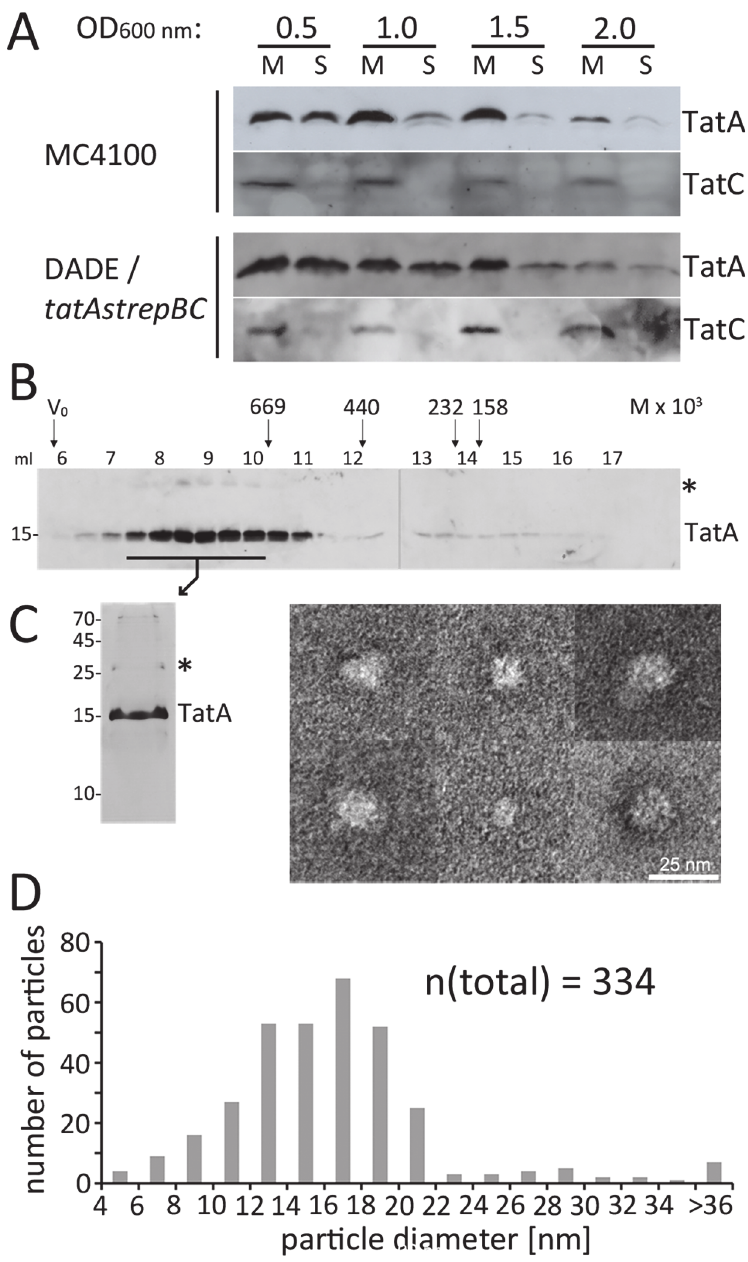
Fig 6. Membrane-detached soluble TatA forms large micellar associations. (A) Soluble TatA is abundant after cell disruption of bacteria at early exponential growth phase. Distribution of TatA in the membrane and cytoplasmic fraction in preparations from cultures of strains MC4100 and DADE tatA-strep- tatBC , harvested at indicated optical densities. Fractionation control was done by detection of the polytopic membrane protein TatC. Samples were normalized to the same amount of cells. (B) Size exclusion chromatography (SEC) of TatA- strep as purified from the cytoplasm after wild-type level production (DADE tatA-strep-BC ) indicates formation of high molecular weight complexes. Western blot analysis of elution fractions; SEC molecular weight markers are indicated at the top (thyroglobulin, 669 kDa; ferritin, 440 kDa; catalase, 232 kDa; aldolase, 158 kDa). (C) Silver-stained SDS-PAGE of purified TatA- strep and analysis of the TatA particles by electron microscopy. Six typical TatA assemblies are shown; see supplement S4 Fig. for an overview micrograph. (D) Statistical analysis of TatA particle diameters based on 334 measured particles. M, membrane fraction; S, soluble fraction; * , TatA dimer. Molecular weight marker positions (in kDa) are indicated on the left of SDS-PAGE